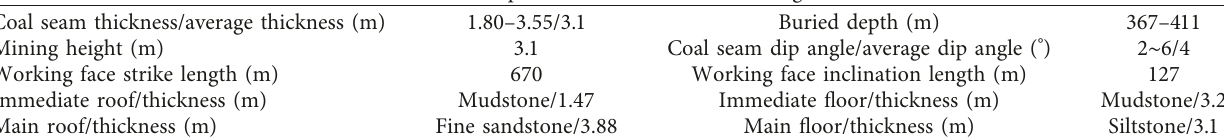
Figure 7: Layout of the 8304 working face. Table 3: Basic parameters of the 8304 working